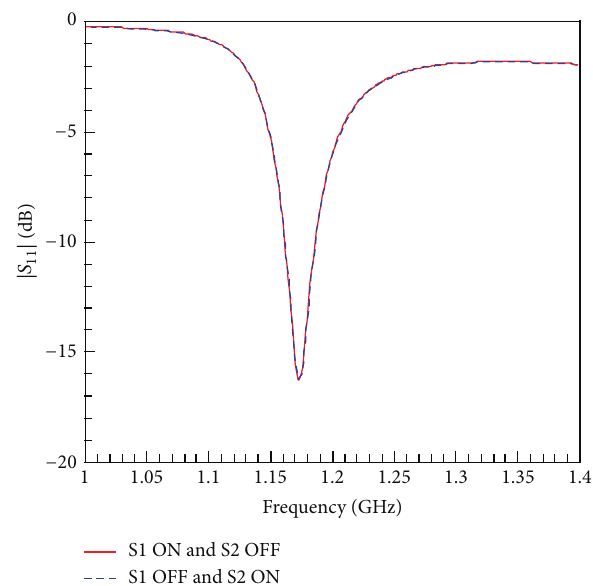
Figure 11: Simulated impedance mismatch of the fabricated prototype of the two-CLL NFRP element reconfigurable antenna.